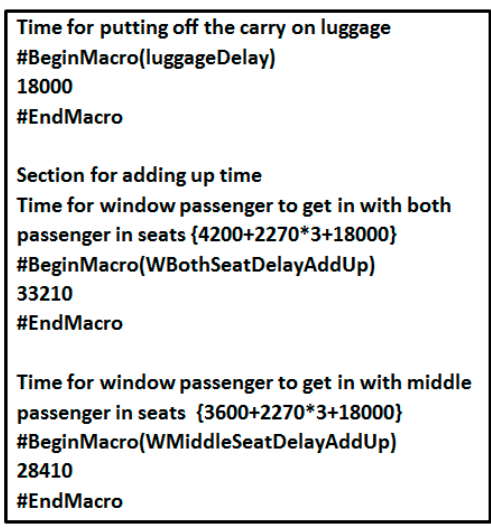
Figure 18. Sample macros defining various delay values based on Table 2 ranges.